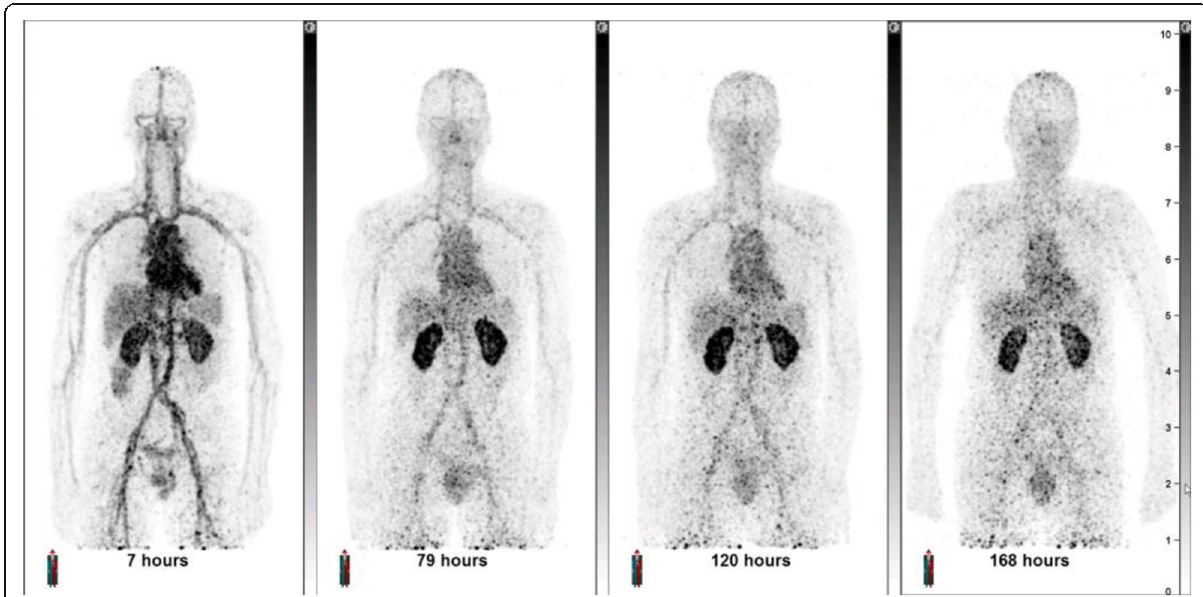
Fig. 1 Maximum intensity projections (MIP) obtained at different time points after administration for one representative subject 135. MIP images for additional subjects 105 and 127 are provided in the Additional file 1: Figures S2 and